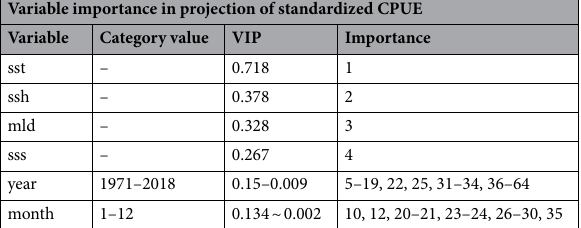
Table 1. PLSR results for importance of environmental variables to YFT